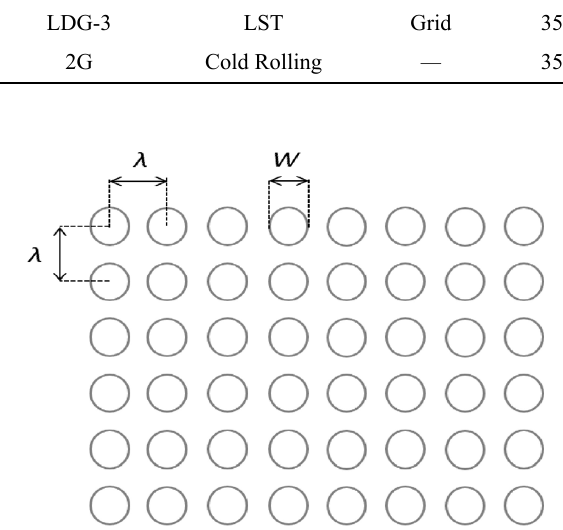
Fig. 1 Texture parameters for crater and grid structures. roughness Sa of the texture denotes the average vertical deviation at the location of the measured surface area, and is greatly influenced by the height of pattern.